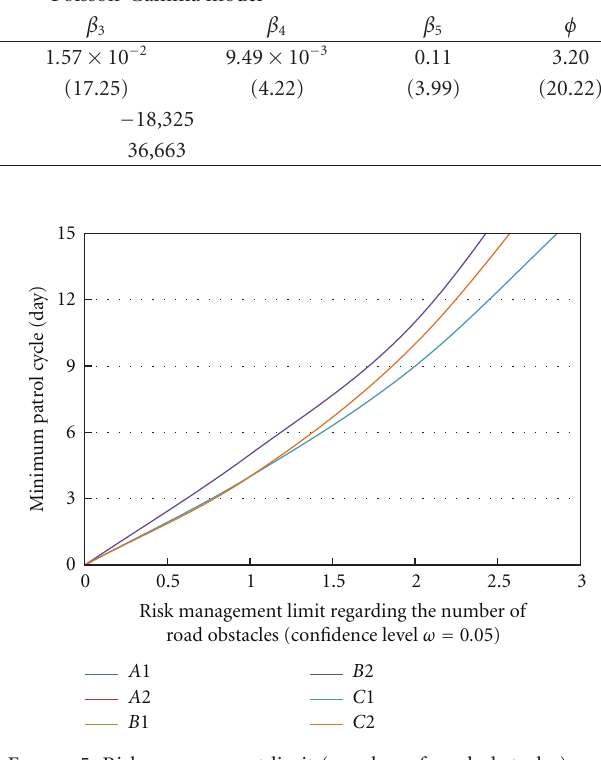
Figure 5: Risk management limit (number of road obstacles) and the minimum patrol cycle (confidence level ω = 0 .